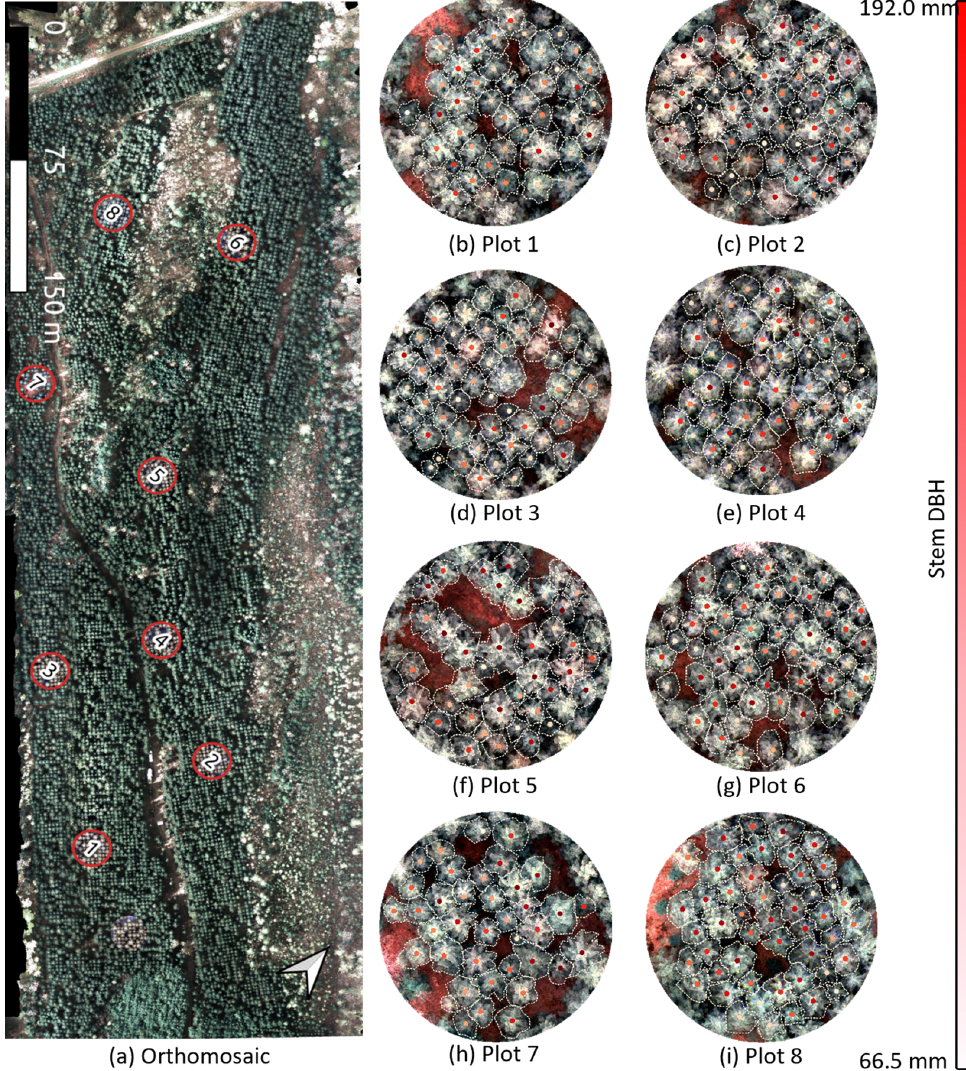
Figure 1. The orthomosiac ( a ) of the St. Casimir forest generated from the VHR multispectral data collected in October 2018. The reference data including the diameter at breast height (represented by coloured dots) and the crown spans (dotted-white-lines) were obtained for every tree in all eight circular plots ( b – i